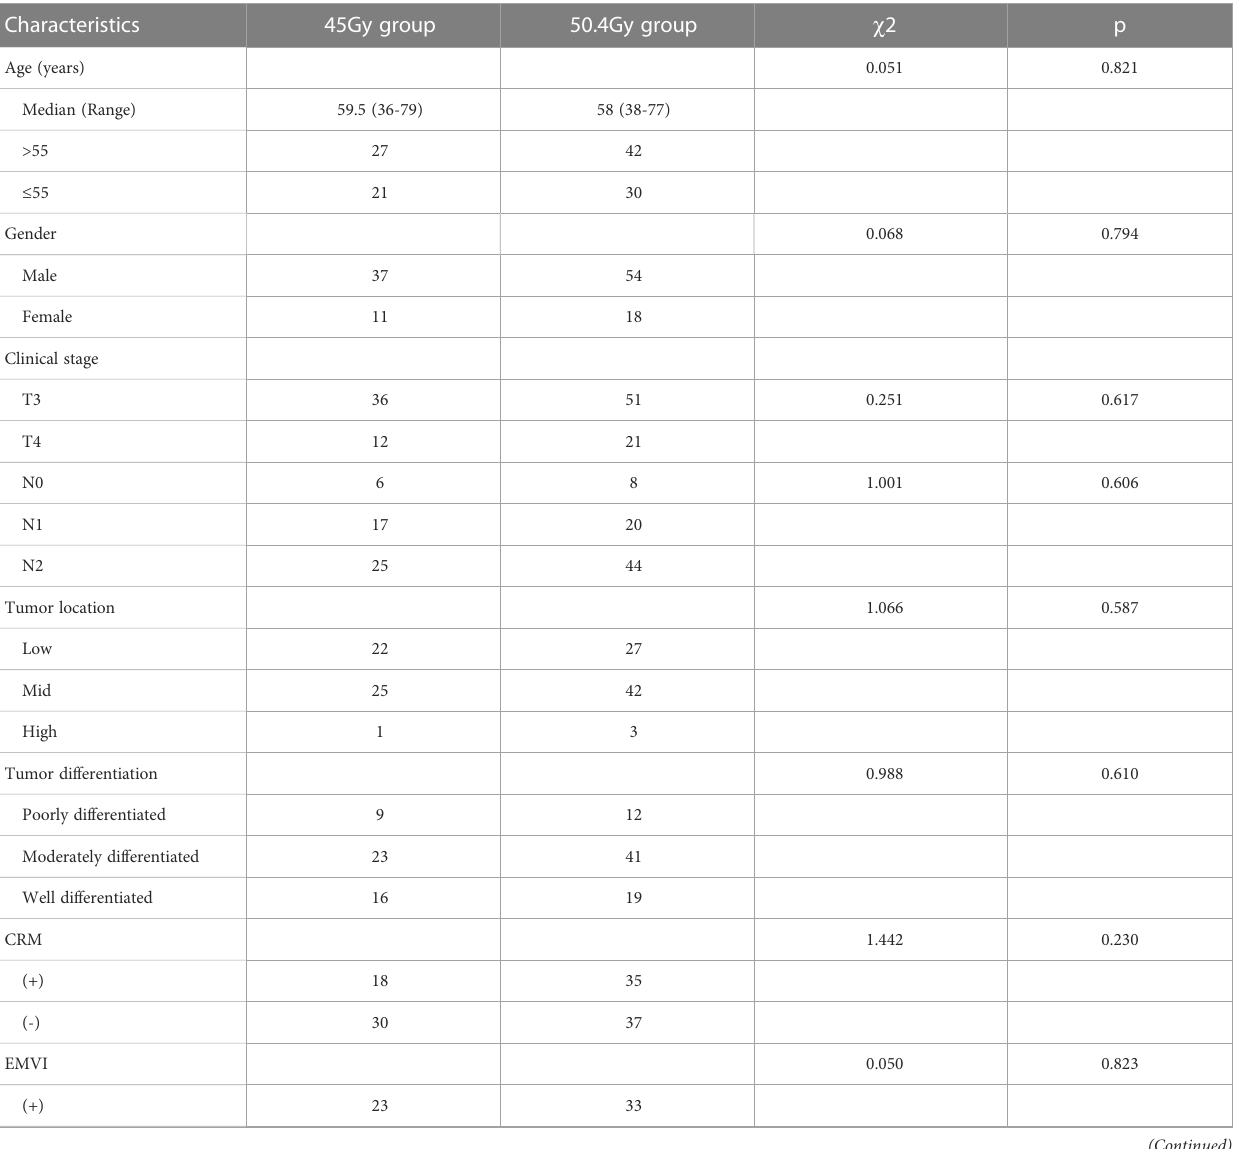
TABLE 1 Baseline characteristics of